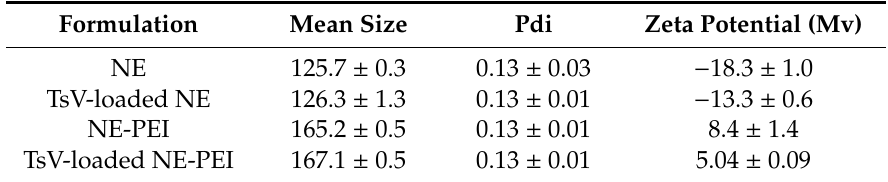
Table 2. Droplet size and zeta potential measurements for di ff erent blank and TsV-loaded NEs stored in hermetically sealed vials at 4 ◦ C, for six